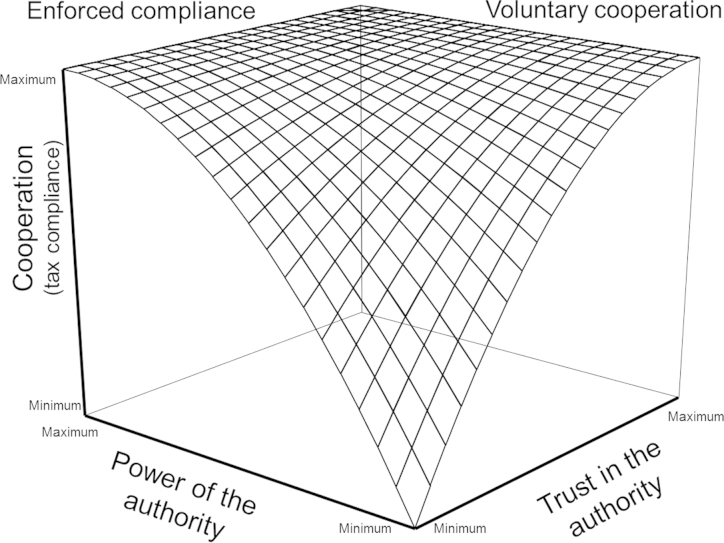
The Slippery Slope Framework (Kirchler, Hoelzl, and Wahl, 2008, p. 212).